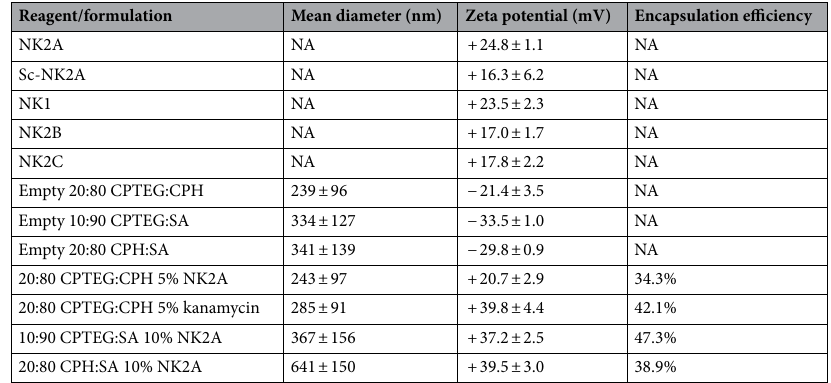
Table 2. Characterization of bovine NK-lysin peptides and polyanhydride nanoparticles. NA not applicable.